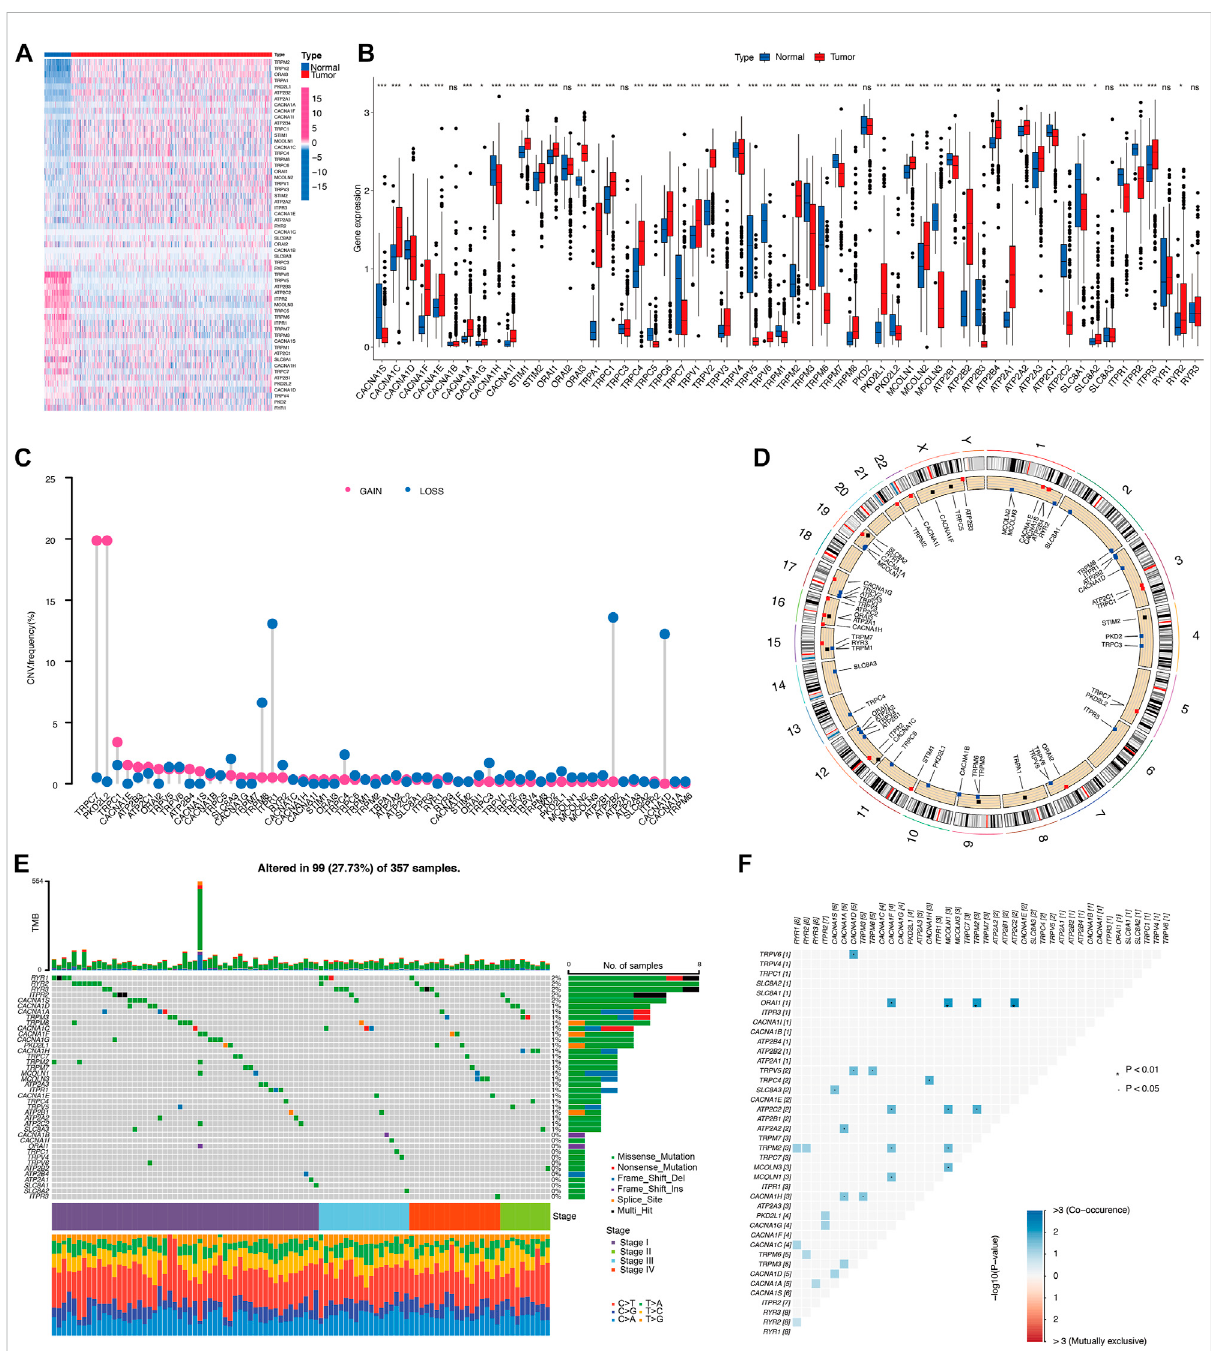
FIGURE 2 Landscapeofcalcium-relatedgenes(CRGs)inTCGAcohort. (A,B) Thedifferentialexpressionof58CRGsinKIRCandnormaltissuesamples. (C) Copy number variation (CNV) status of 58 CRGs. (D) The location of CNV in chromosome. (E) Differential somatic mutations of CRGs. (F) Co- occurrence of mutations of